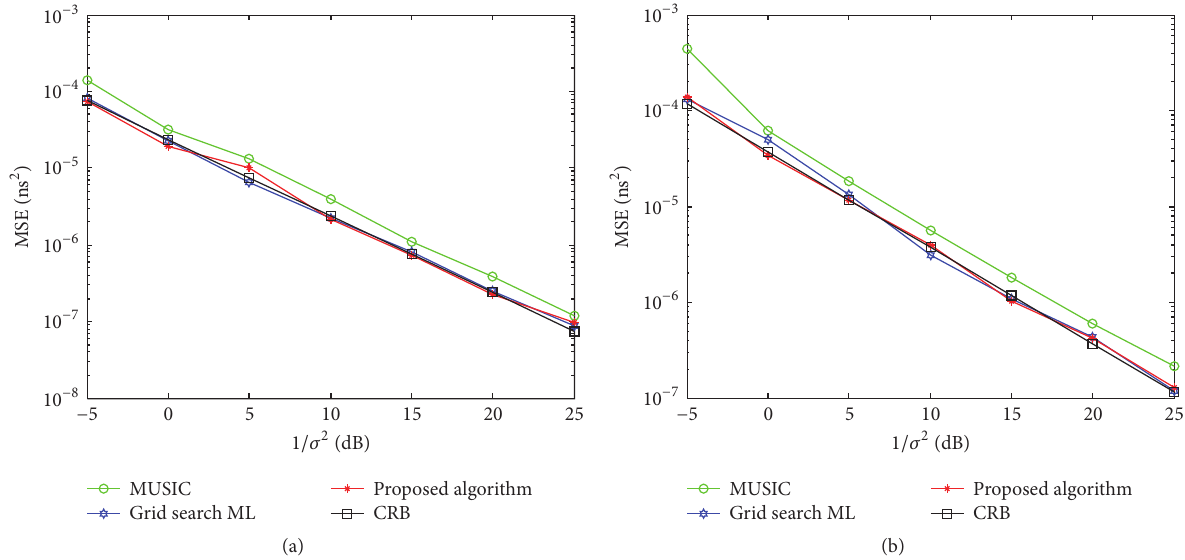
Figure 2: (a) Time delay performance comparisons of the 1st multipath component. (b) Time delay performance comparisons of the 2nd multipath